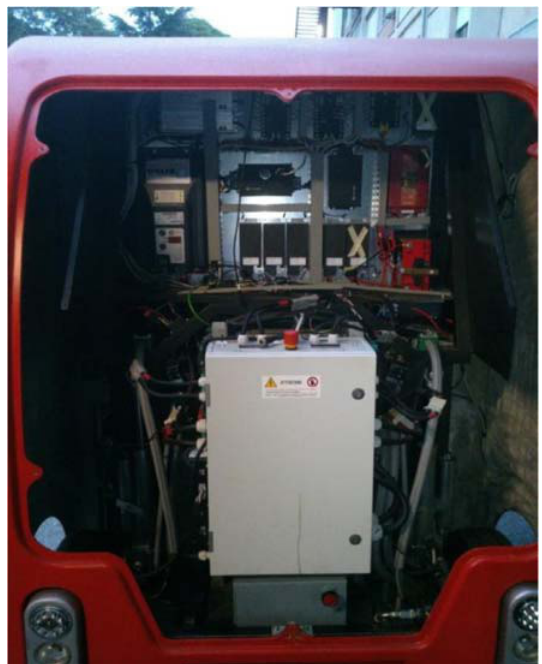
Figure 9. Back of FURBOT.